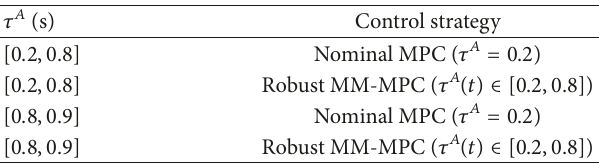
Table 1: Simulation scenarios for a homogeneous platooning control